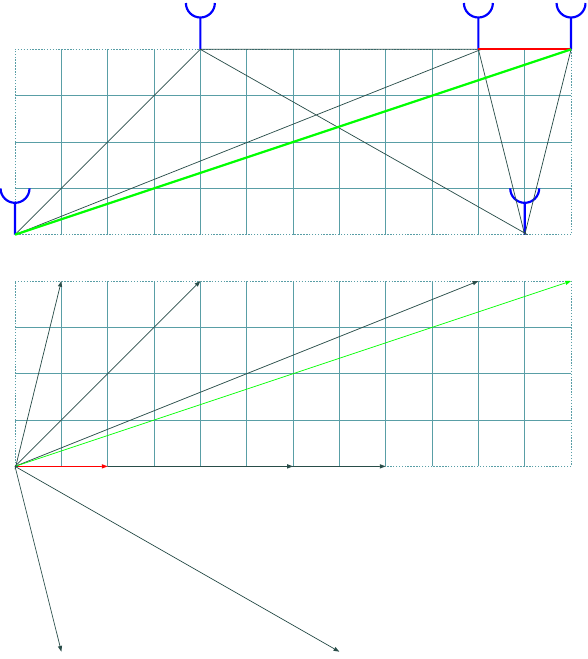
Fig. 2. Representation of the 30MHz radar interferometry antenna array. (Top panel) Physical locations of the phase centers of the antenna groups used for reception. Up in this figure is in the direc- tion of the main beam of the transmitting antennas. Grid lines are spaced by 5/4 wavelengths. (Bottom panel) Representations of the nine corresponding antenna baselines available for interferometry. These lines are the same as the nine lines drawn above, displaced so as to have a common origin. The shortest and longest baselines are highlighted in red and green, respectively, for emphasis.